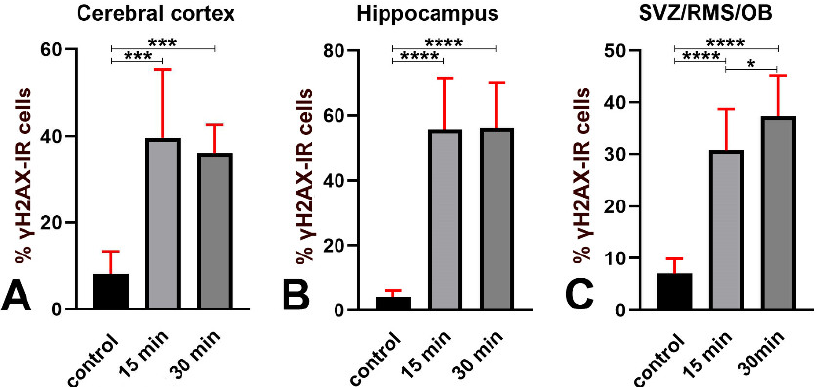
Figure 4. Percentages of γH2AX immunoreactive nuclei versus the total number of nuclei after labeling with DAPI in the cerebral cortex ( A ), hippocampus ( B ), and SVZ/RMS/OB ( C ) in control and irradiated mice. * 0.05 > p ≥ 0.01, *** 0.001 > p ≥ 0.0001, **** p < 0.0001. Bars are 95% CI. Immunostaining was performed with the Abcam antibody. Numbers of statistical data are reported in Appendix E.